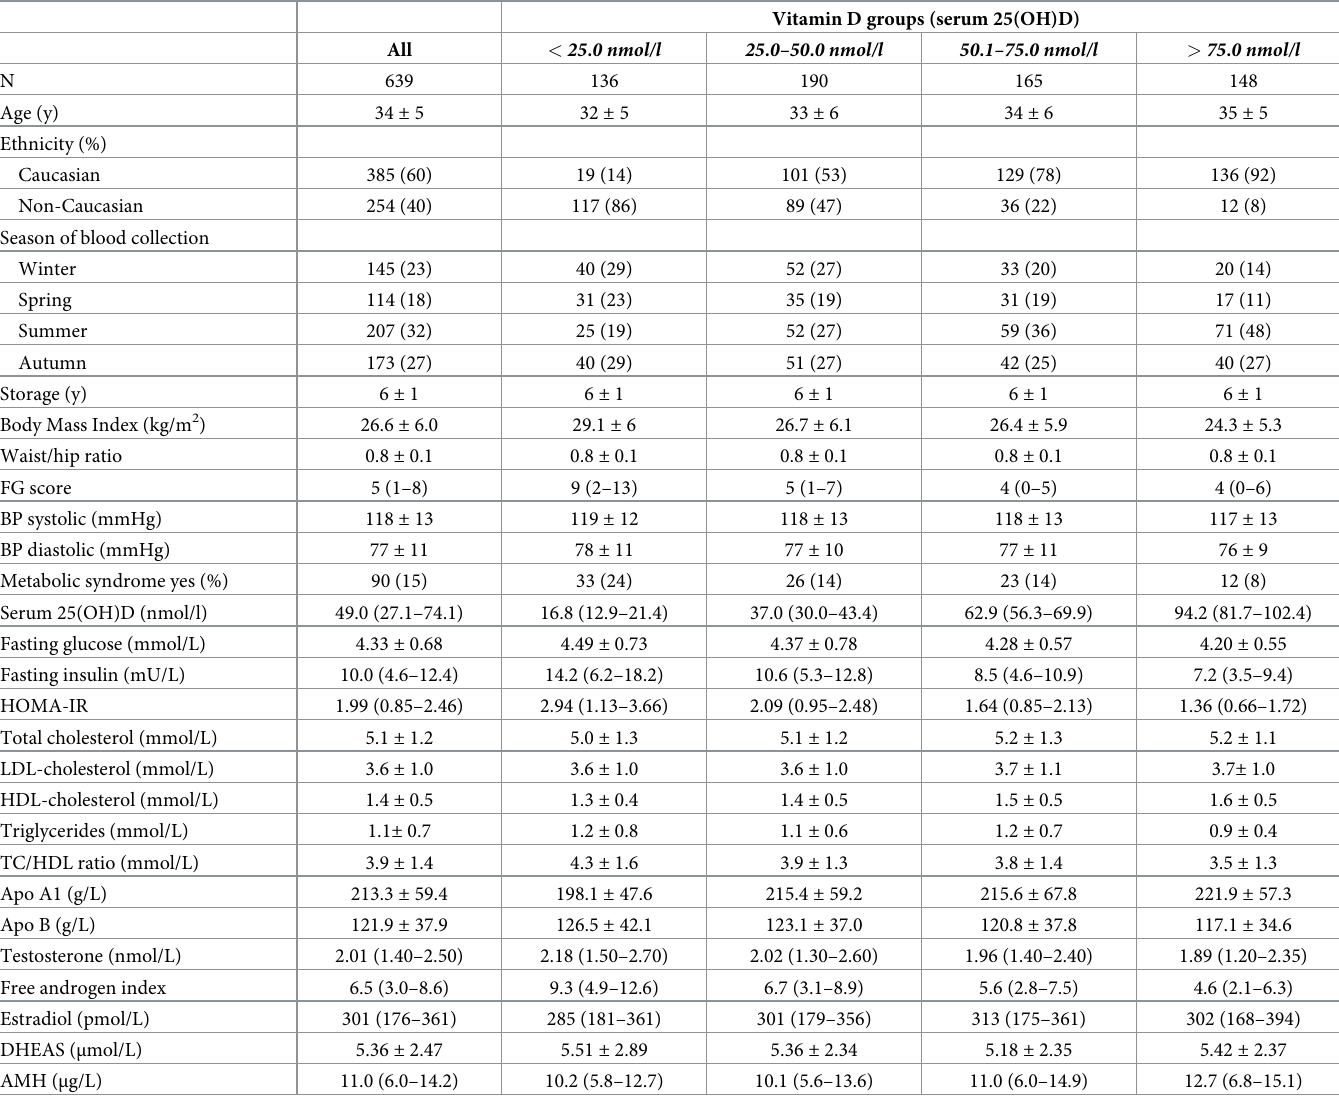
Table 3. Baseline demographic and clinical